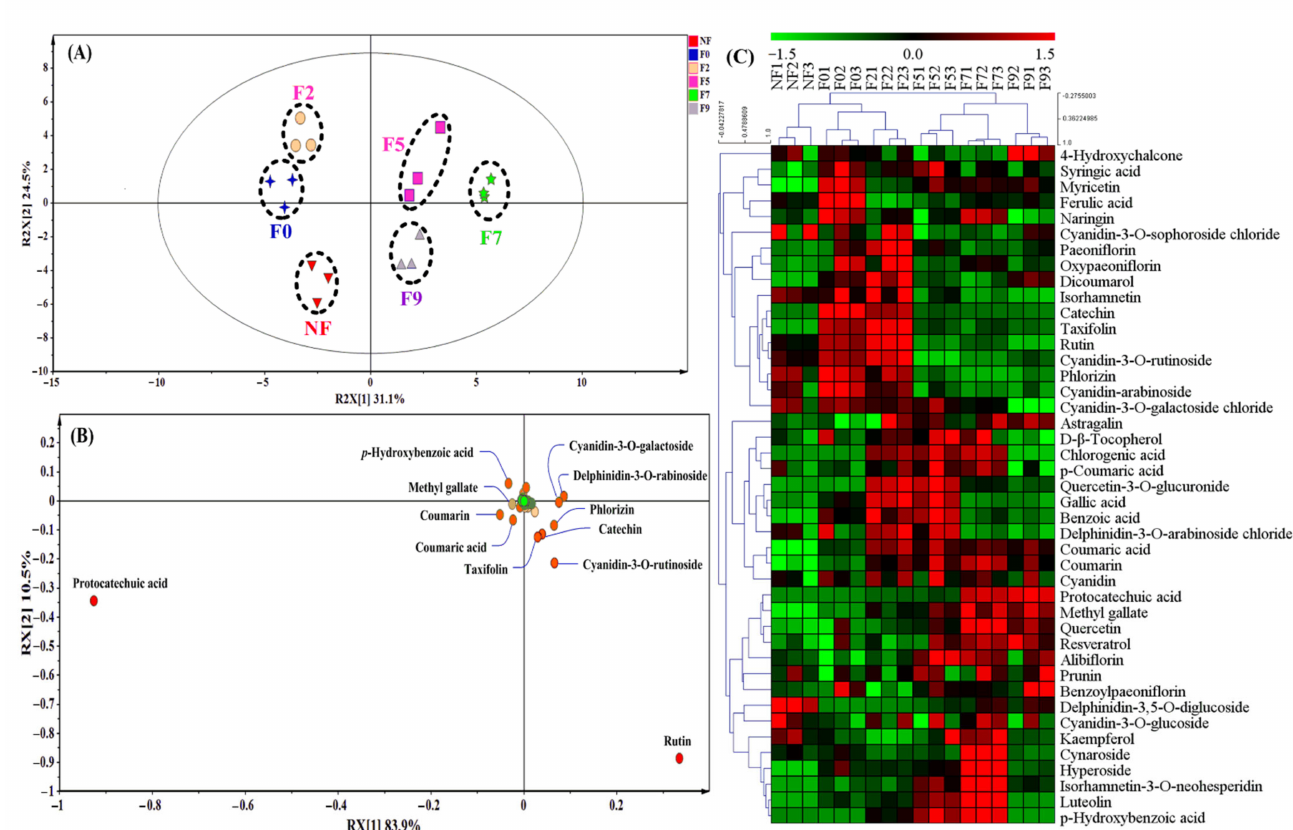
Figure 3. Qualitative and quantitative analysis of polyphenol compounds in fermented Chinese jujube by M. purpureus . ( A ): PCA score plot, ( B ): PCA loading plot, ( C ): heat map of HCA analysis. F0, F2, F5, F7 and F9 represented the samples collected at 0, 2, 5, 7 and 9th day of the fermentation, respectively. NF represented the unfermented